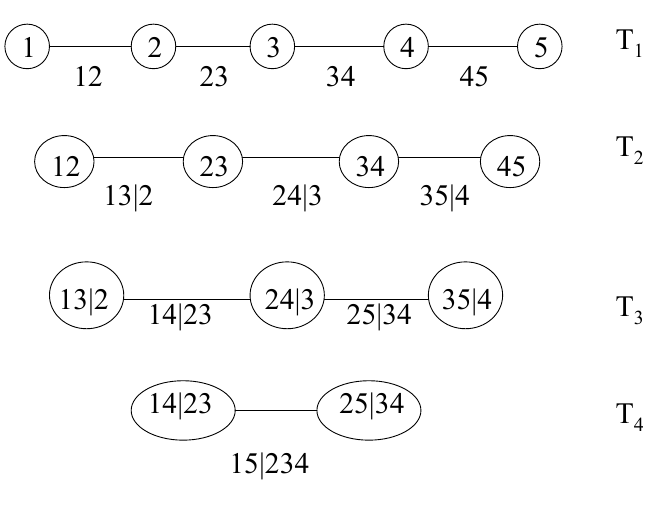
Figure 1: A D-vine with 5 variables, 4 trees and 10 edges. Each edge may be may be associated with a pair-copula.